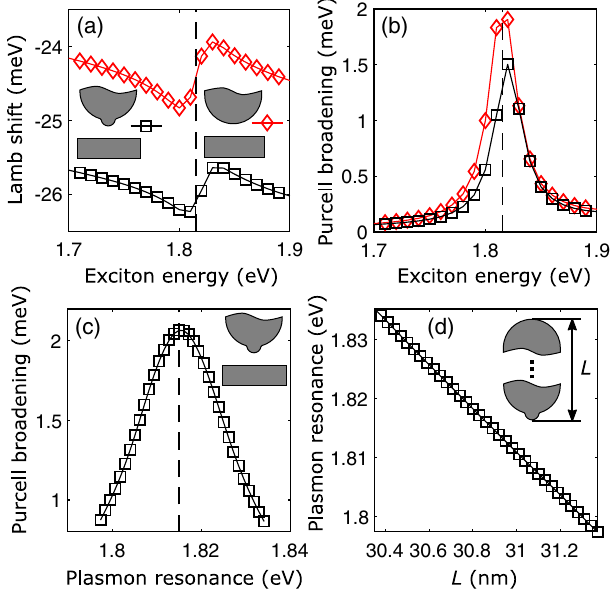
FIG. 7. Spectral dependence of the Lamb shift and the Purcell effect. (a) Lamb shift calculated as a function of the exciton frequency for the picocavity (black squares) and the blunt tip (red diamonds). (b) Broadening of the excitonic peak due to the Purcell effect for the picocavity (black squares) and the blunt tip (red diamonds). The dashed black line marks the exciton energy of 1.815 eV considered for the calculation of the spatial dependence of the Lamb shift and the Purcell effect in this work. (c) Dependence of the Purcell broadening on the plasmon resonance of the tip. The tip is positioned as in panels (a,b), and the total length L of the tip is varied to tune the resonance of the dipolar plasmon. The exciton energy is fixed at 1.815 eV. The plasmon resonance of the tip as a function of the tip length L is shown in panel